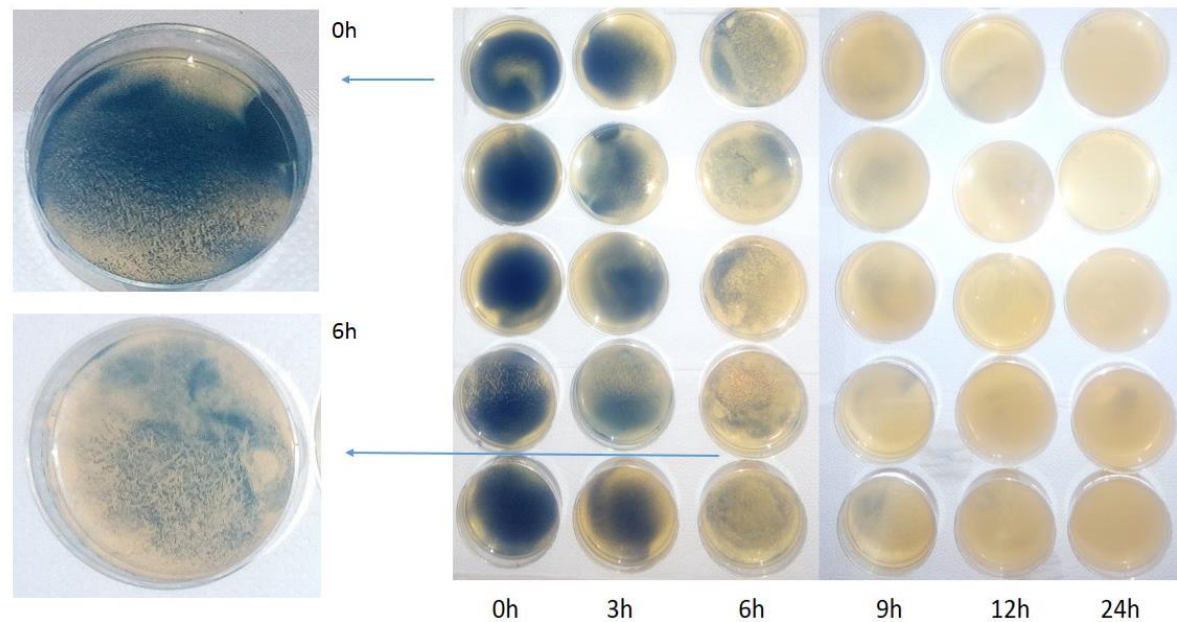
Figure 4. Petri dishes with biological materials of nasopharyngeal secretions from infected virus Sars-CoV-2 patients after 0 – 24 h incubation treatment with Salistat SGL03 (see Section 2.1).